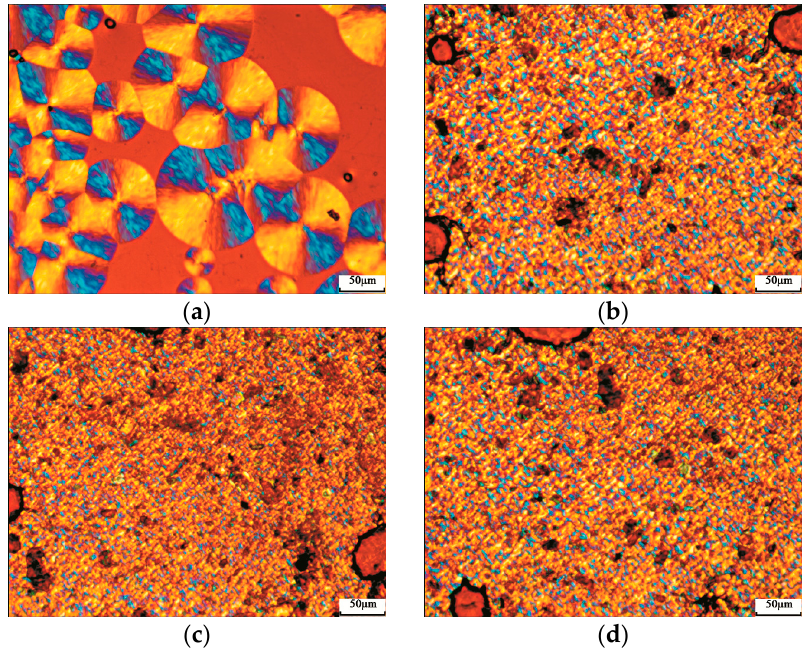
Figure 6. Polarized light images of isothermally crystallized samples. ( a ) PLA; ( b ) PLA/PF (70 wt %/30 wt %); ( c ) PLA/T-PF (70 wt %/30 wt %); ( d ) PLA/PBAT/T-PF (60 wt %/10 wt %/30 wt %).